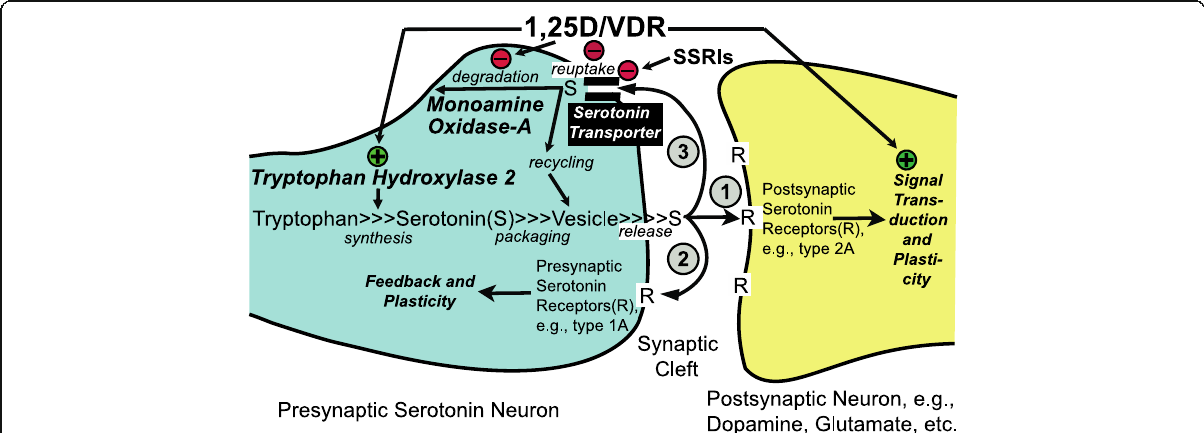
Fig. 6 Actions of 1,25D/VDR on serotonin dynamics in the CNS at the serotonin synapse. This model depicts the fine-tuning of serotonin levels by 1,25D via transcriptional regulation of TPH2 , SERT , and MAO-A ; the result of which is the potentiation of serotonergic nerve transmission. Initially, (left) 1,25D induces TPH2 to enhance serotonin output and, because circled pathway 3 (reuptake and degradation) is attenuated by 1,25D via repression of SERT and MAO-A , serotonin action is spurred at both presynaptic (circled pathway 2) and postsynaptic (circled pathway 1) sites through type 1A and 2A serotonin receptors,